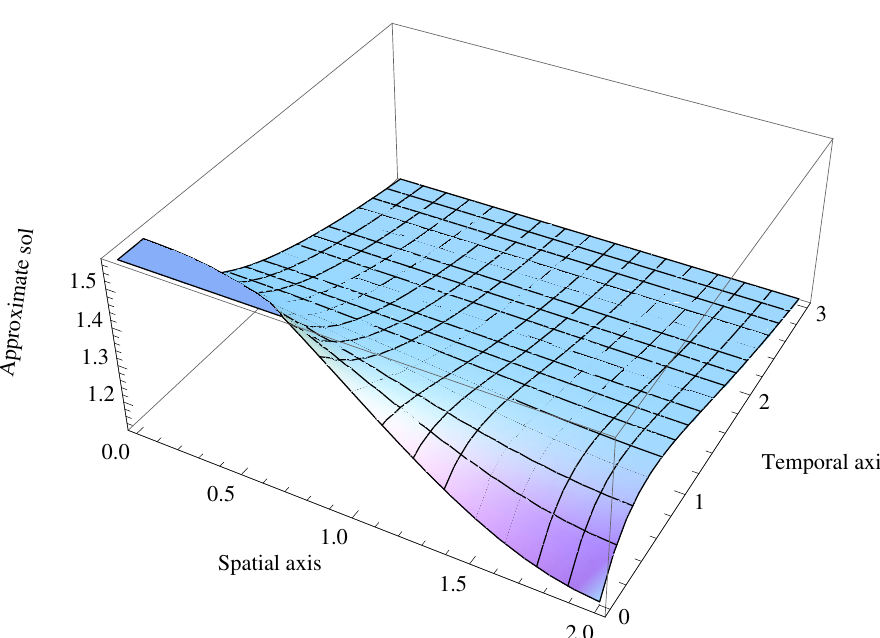
Figure 6. Approximated Solution for Fisher’s Equation t ∈ [ 0,3 ]